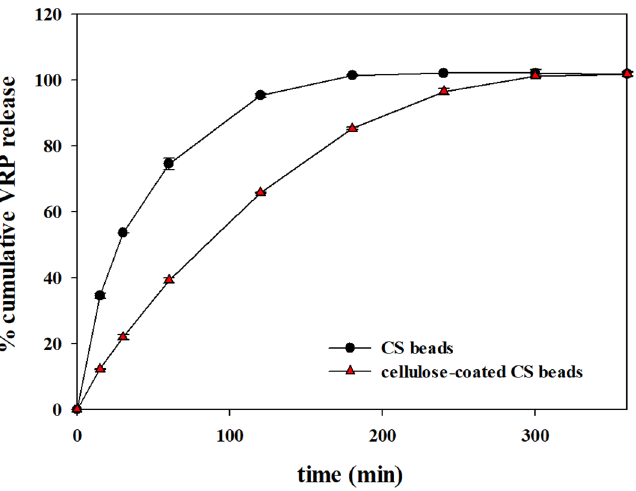
Figure 7. Release patterns of VRP in SIF from CS beads and cellulose-coated CS beads. The in vitro release experiment was performed at 100 rpm and 37 ± 0.5 °C. The concentration of VRP was analyzed by taking a sample of 0.5 ml from 50 ml of SIF